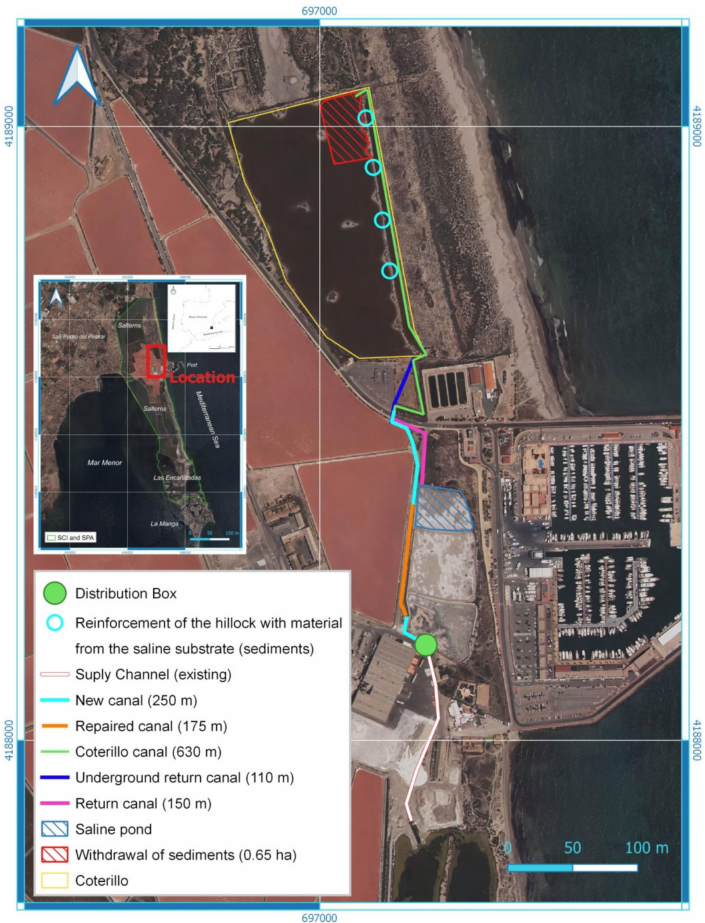
Figure 5. Connection of the Coterillo pond with the salt circuit (Source: